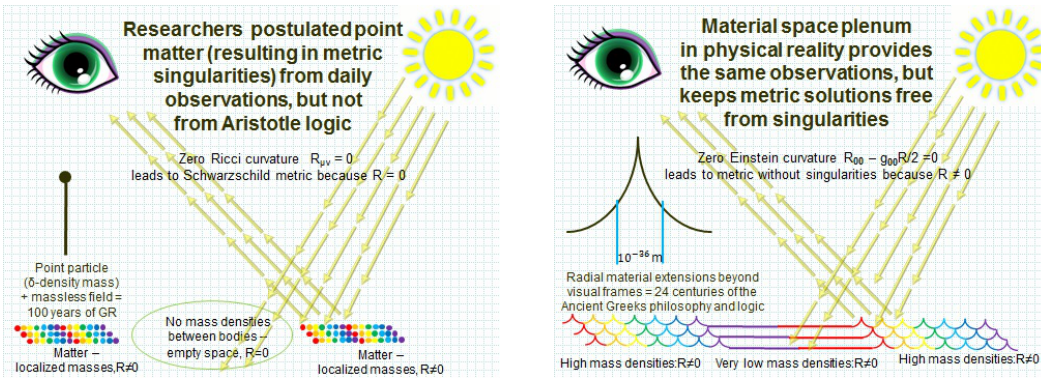
Figure 1. Newtonian particles and empty space vs. Cartesian non-dual